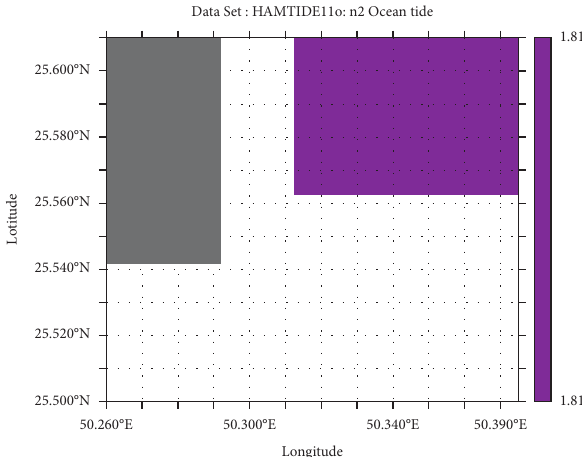
Figure 7: Amplitude in cm of 2N